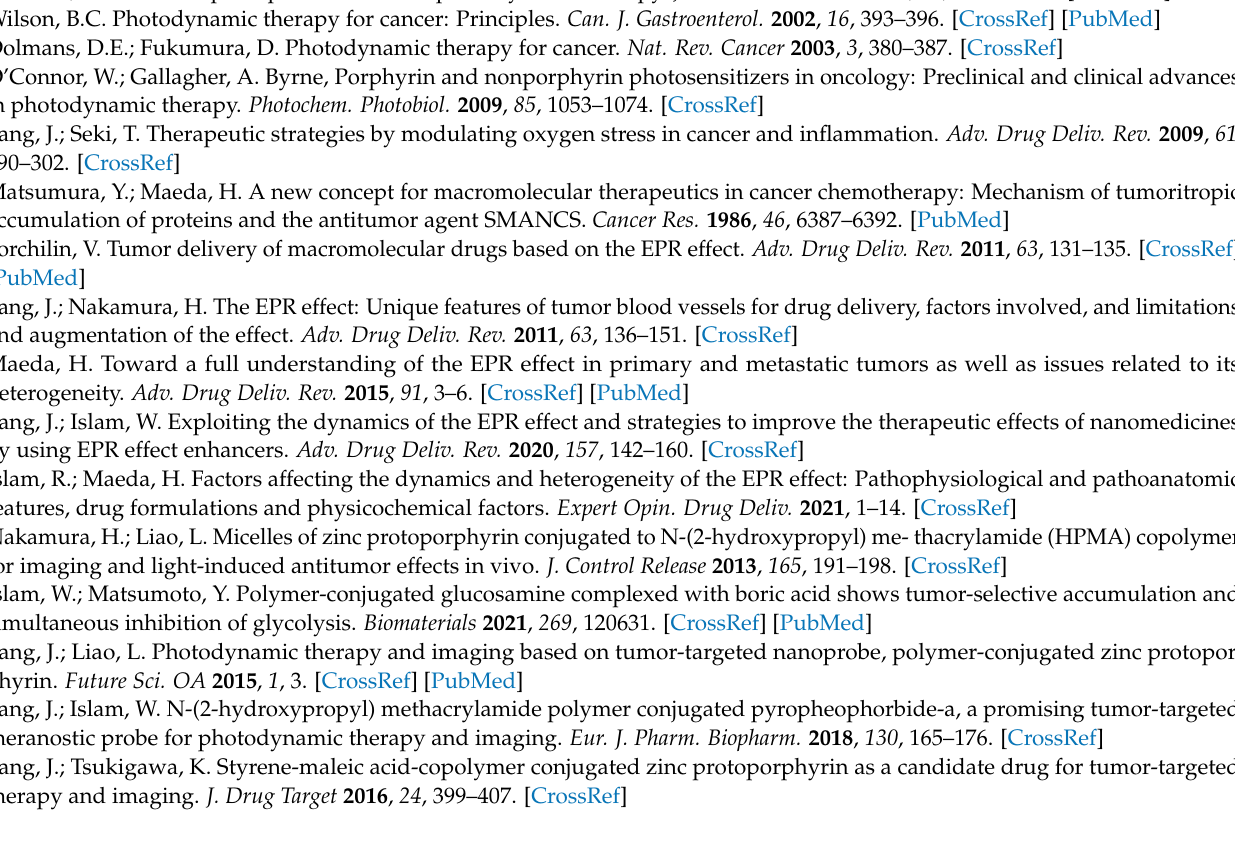
Figure S2: Standard curve of mTHPC in DMSO as measured by fluorescence (Ex420nm/Em590nm), Figure S3: Pictures of SMA@mTHPC solution in PBS, Figure S4: Pictures of mice after free